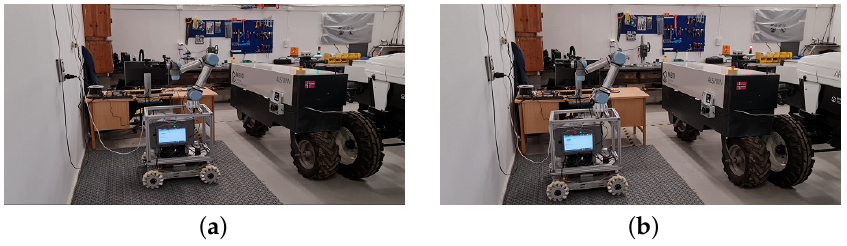
Figure 12. Sequence 1: aligning the ACS to the wall-plug. ( a ) Seq 1.1: The ACS at the initial position. ( b ) Seq 1.2: The ACS aligned to the wall-plug.